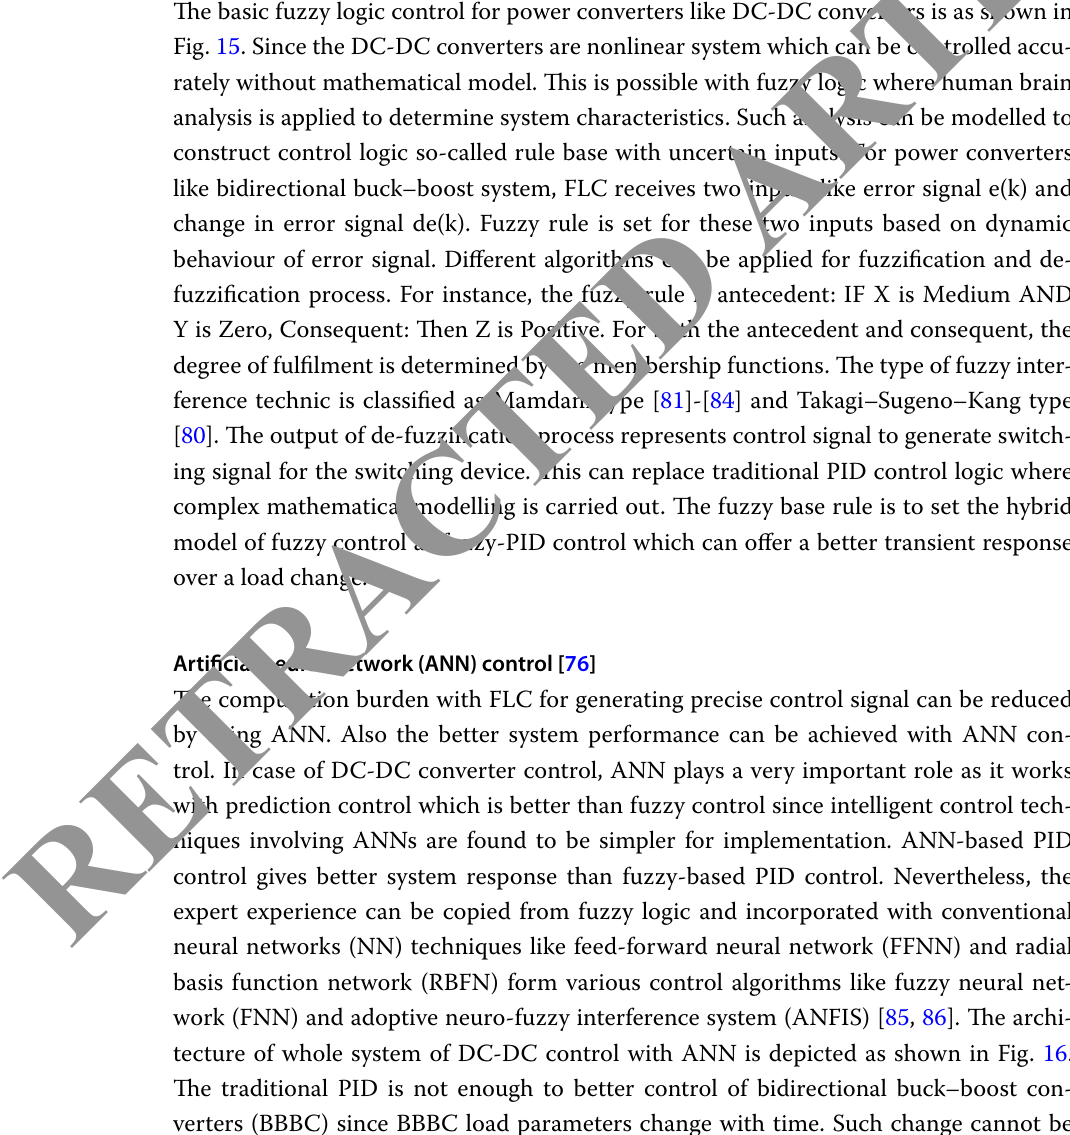
Fuzzy logic control (FLC)